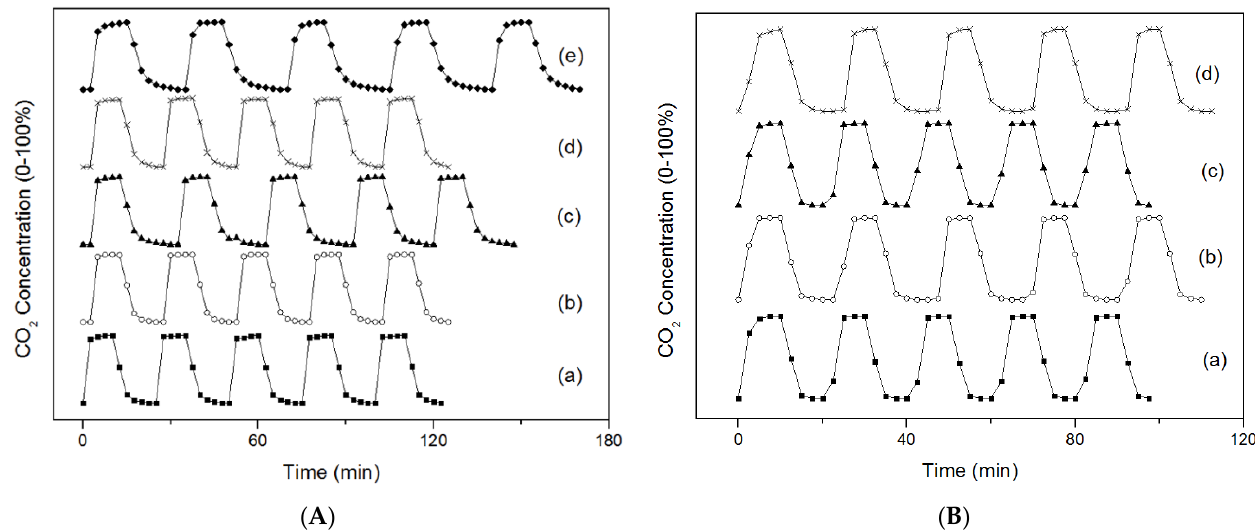
Figure 6. ( A ) The CO 2 adsorption/desorption cycles of (a) Na-SSZ-13-meso-0.2, (b) Na-SSZ-13-meso-0.4, (c) Na-SSZ-13-meso-0.6, (d) Na-SSZ-13-meso-0.8, and (e) Na-SSZ-13-micro; ( B ) CO 2 adsorption cycles of (a) H-SSZ-13-meso-0.2, (b) H-SSZ-13-meso-0.4, (c) H-SSZ-13-meso-0.6, and (d) H-SSZ-13-micro.